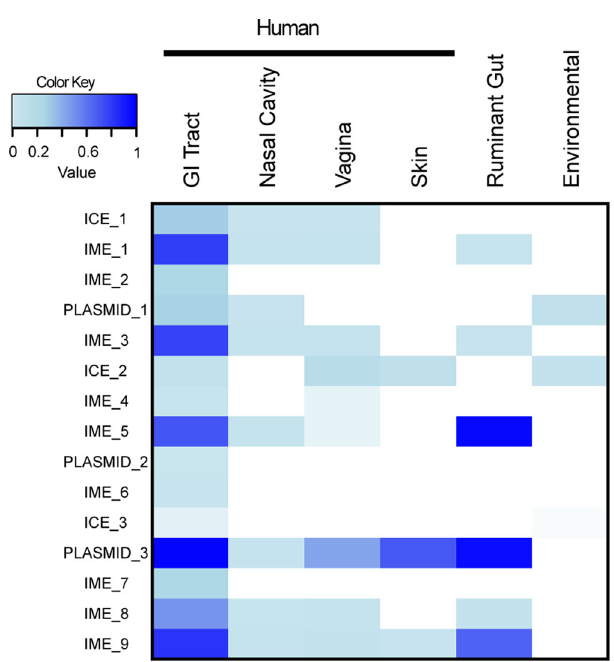
Fig. 4 Prevalence of the promiscuous mobile elements in human body, ruminant gut, and environmental microbiomes. Prevalence of promiscuous elements across the human gastrointestinal tract, nasal cavity, vagina, skin, ruminant gut, and environmental samples. Blue represents the frequency with which an element was detected within a metagenomic sample derived from the site. No detection is represented in